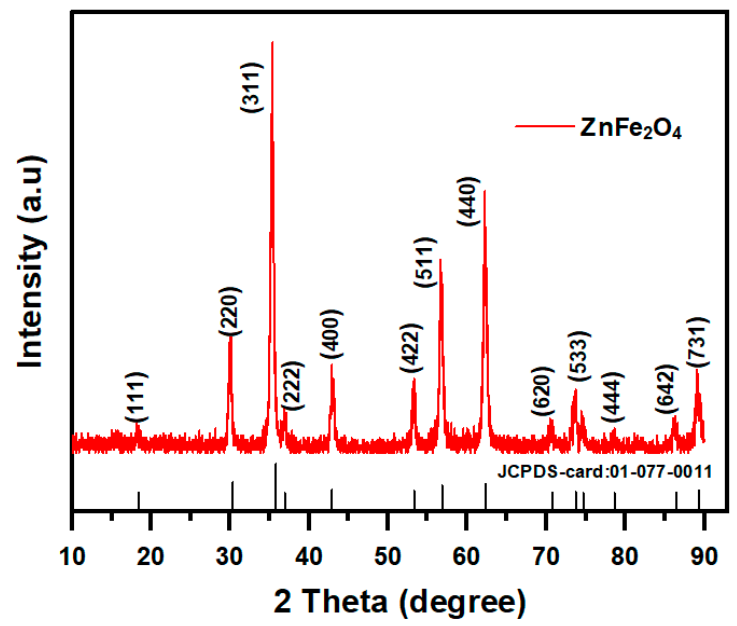
Figure 2. XRD spectrum of ZFNPs and JCPDS card.